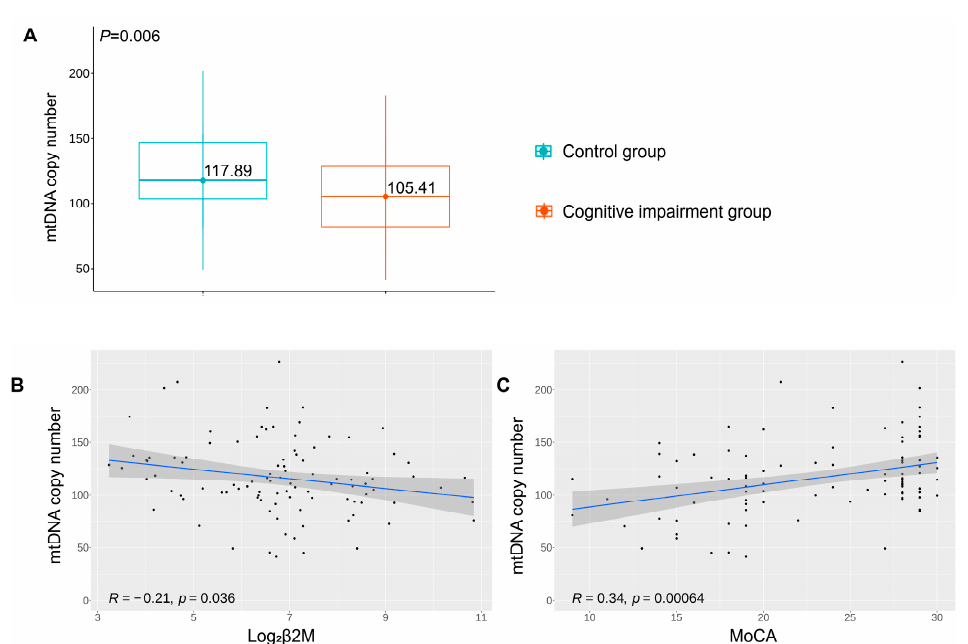
Figure 6. ( A ) mtDNA copy content in peripheral blood between the two groups of study participants. ( B ) Spearman correlation analysis of mtDNA content and log 2 β 2M. ( C ) Spearman correlation analysis of mtDNA content and MoCA scores.